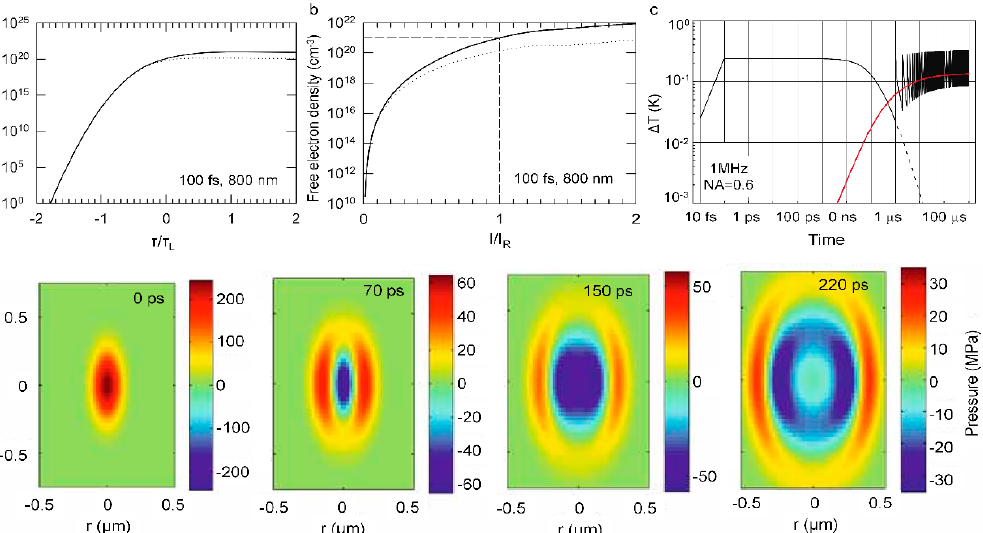
Figure 16. ( a ) Temporal evolution (normalized by pulse duration τ L ) and ( b ) intensity dependence (the irradiance I is normalized by the threshold irradiance I R ) of the free-electron density during the laser pulse at the optical breakdown threshold for 100 fs, 800 nm pulses. ( c ) Temperature evolution at the center of the laser focus that is produced by 1 MHz, 100 fs, 800 nm focused into water. ( d ) Thermo-elastic stress evolution for a peak temperature of 200 °C, slightly above the threshold for bubble formation [252].